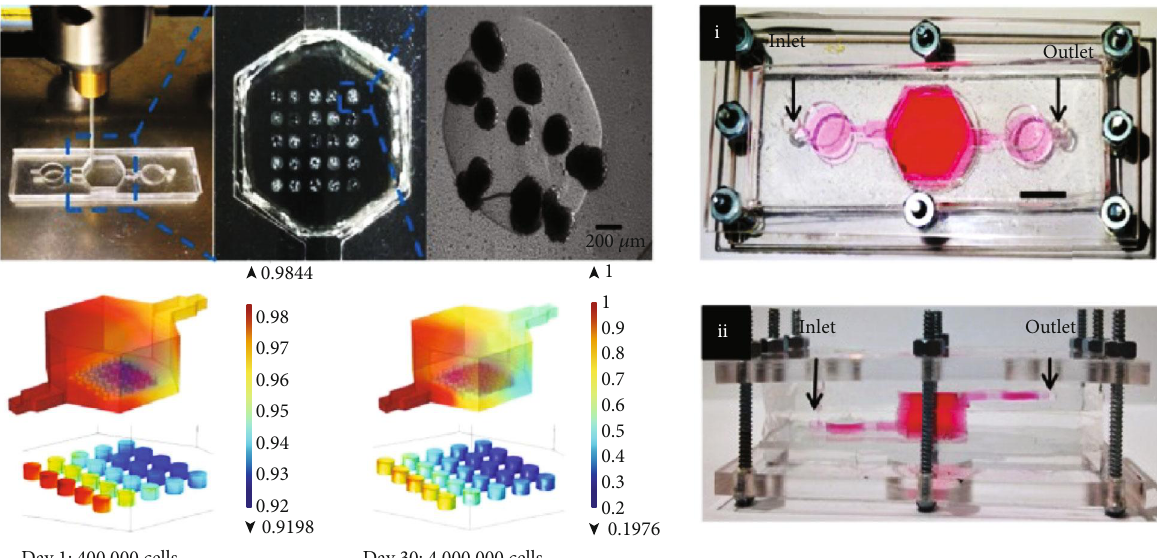
Figure 4: Bioprinting GelMA hydrogel-based hepatic construct within the bioreactor as a dot array. Top view (i) and side view (ii) of the assembled bioreactor with the inlet and outlet fl uidic ports as indicated along with the oxygen concentration. Reproduced (or adapted) with permission [23], ©2018, IOP Science.